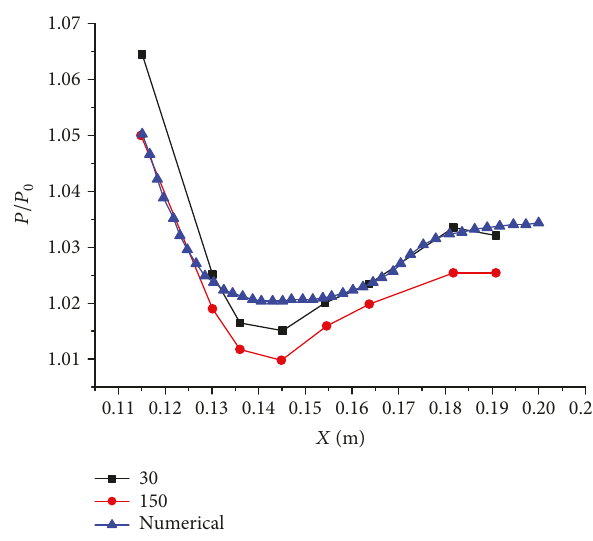
Figure 16: Pressure distribution on the under wall of fl ame